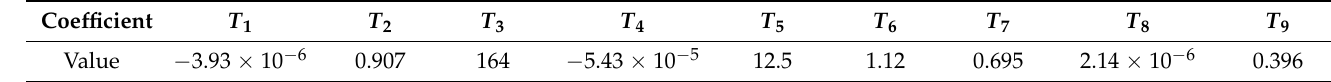
Table 2. Coefficients of the longitudinal force